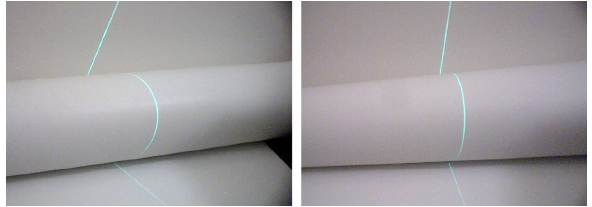
Figure 3. Node matches in four stereo-pairs of the chess-board pattern which were established thanks to the epipolar constraint and then involved in the stereo-camera calibration adjustment.